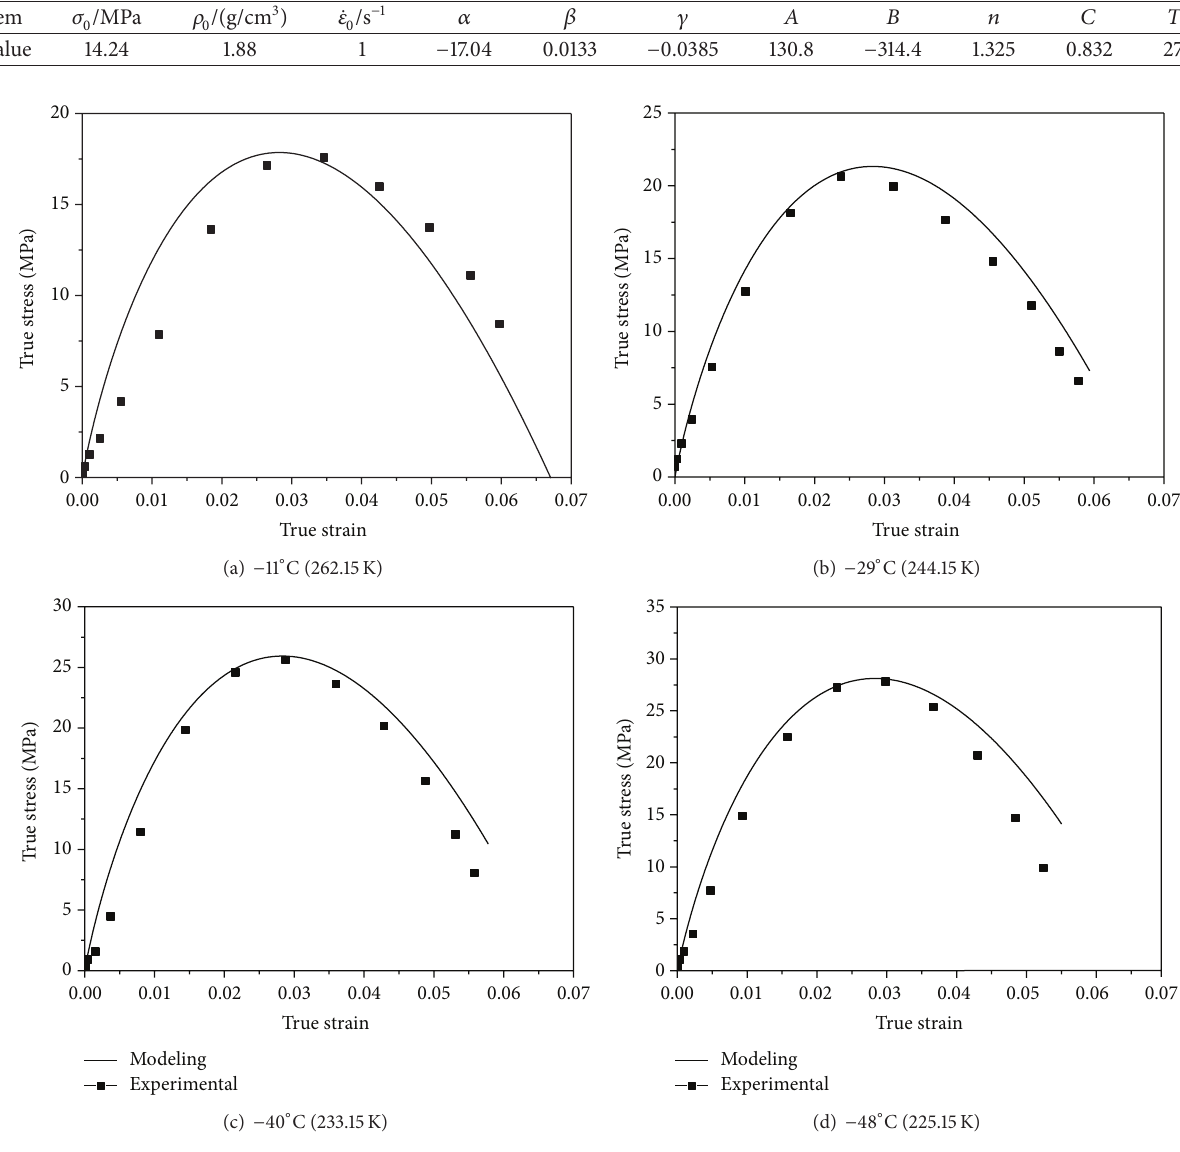
Figure 4: Comparison between model predictions and experimental results at different